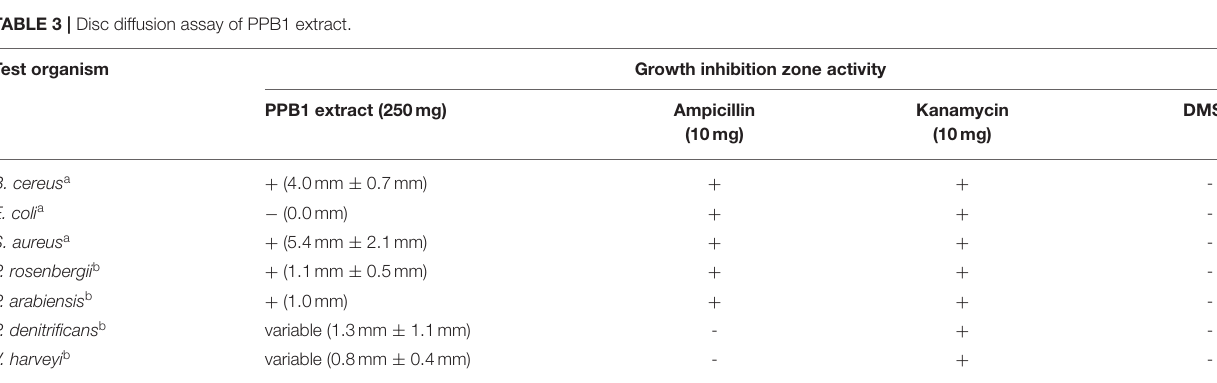
TABLE 3 | Disc diffusion assay of PPB1